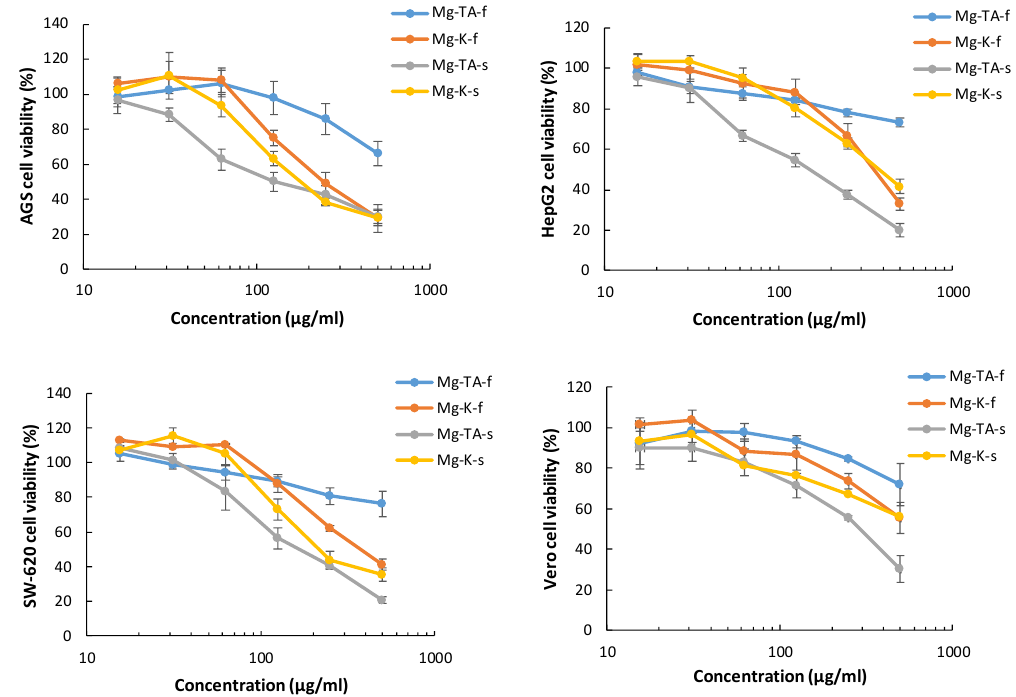
Figure 12. Cytotoxicity dose–response curves of M. indica extracts on AGS, HepG2, and SW620 adenocarcinoma cell lines and Vero normal cell lines. Results are presented as mean ± SD of three independent experiments. Mg-TA-f (T. Atkins cultivar flesh), Mg-K-f (Keitt cultivar flesh), Mg-TA-s (T. Atkins cultivar skin), and Mg-K-s (Keitt cultivar skin).